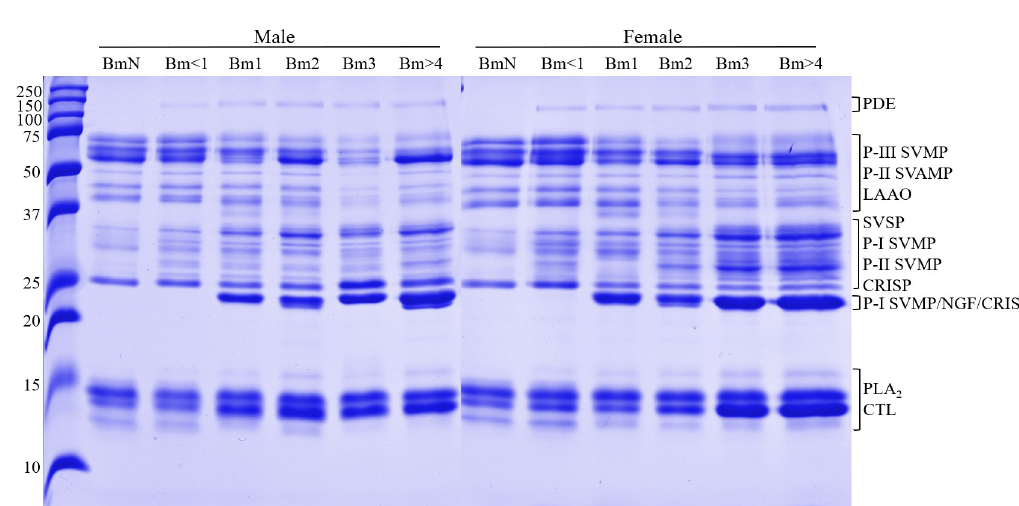
Fig 2. One-dimensional electrophoresis (1-DE, 15%) profiles of male and female B . moojeni at different ages. The samples (20 μ g) were applied to the gel under reducing conditions ( β -mercaptoethanol) and the protein bands were stained with Coomassie Blue G-250, according to the manufacturer’s recommendation. Molecular weight markers (Dual Color Precision Plus, BioRad) are shown on the left side. PDE: phosphodiesterase; SVMP: snake venom metalloprotease; LAAO: L-amino acid oxidase; SVSP: snake venom serine protease; CRISP: cysteine-rich secretory protein; NGF: nerve growth factor; PLA 2 : phospholipase A 2 ; CTL: C-type